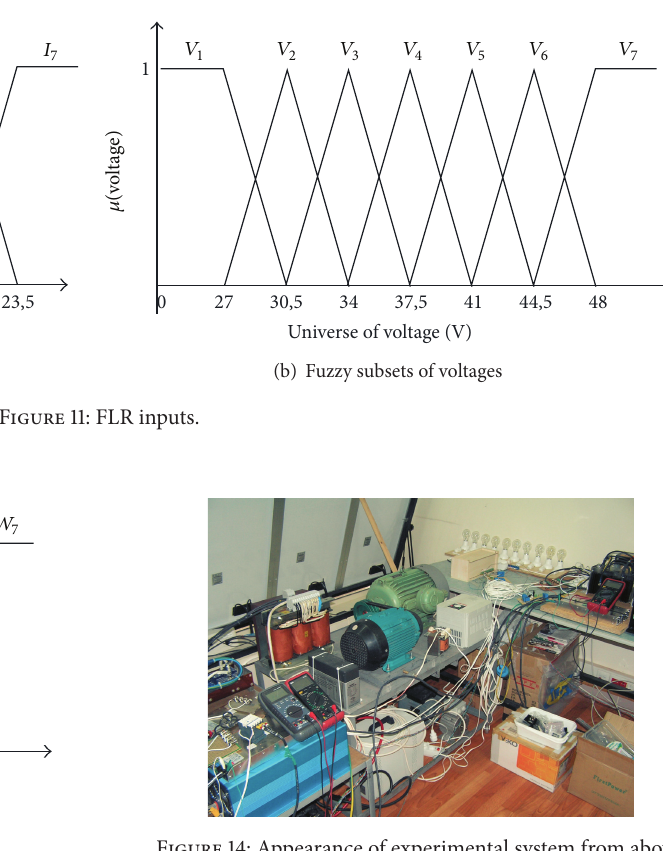
Figure 14: Appearance of experimental system from